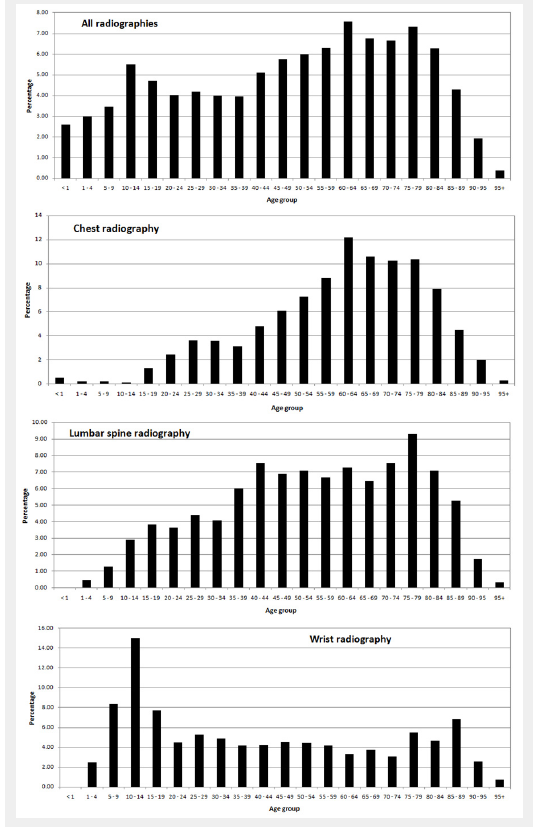
Patient age distributions for all radiological examinations and specific for chest, lumbar spine and wrist, extracted from the 2008 data of CHUV.